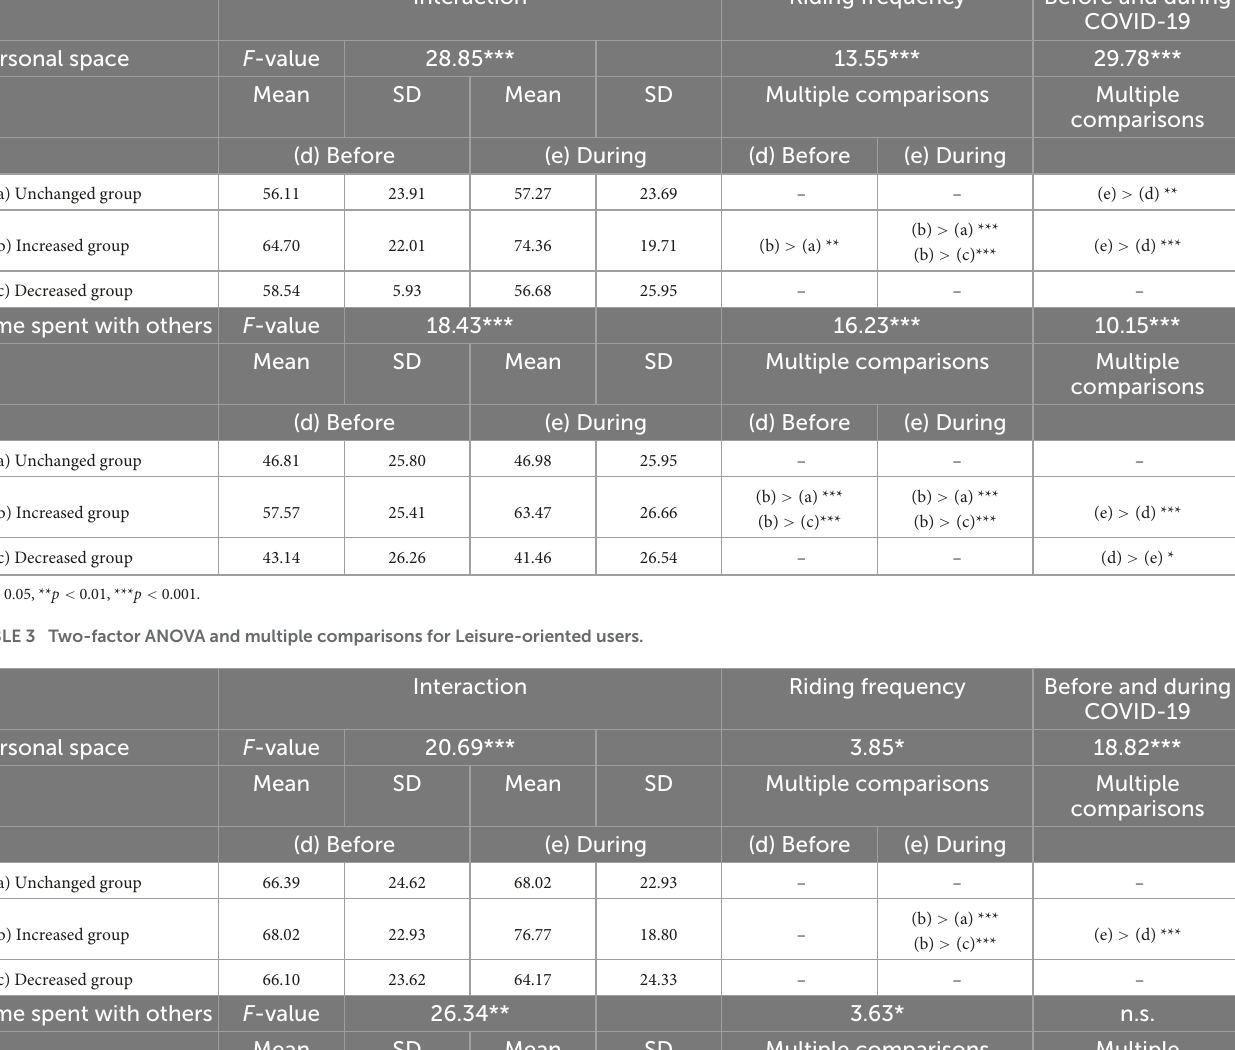
TABLE 2 Two-factor ANOVA and multiple comparisons for daily users. Interaction Riding frequency Before and during